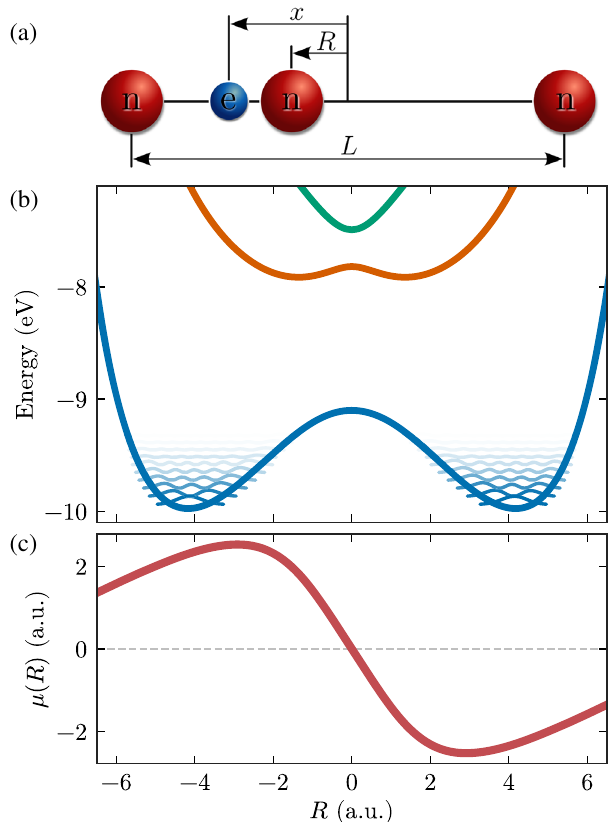
FIG. 1. (a) Schematic representation of the Shin-Metiu model close to one of the equilibrium configurations. The two ions on both sides are fixed at a distance L , while the electron and the remaining ion can move freely in between. (b) Potential energy surfaces of the model with the vibrational levels and associated probability densities of the ground state (blue curve) represented. (c) Ground-state dipole